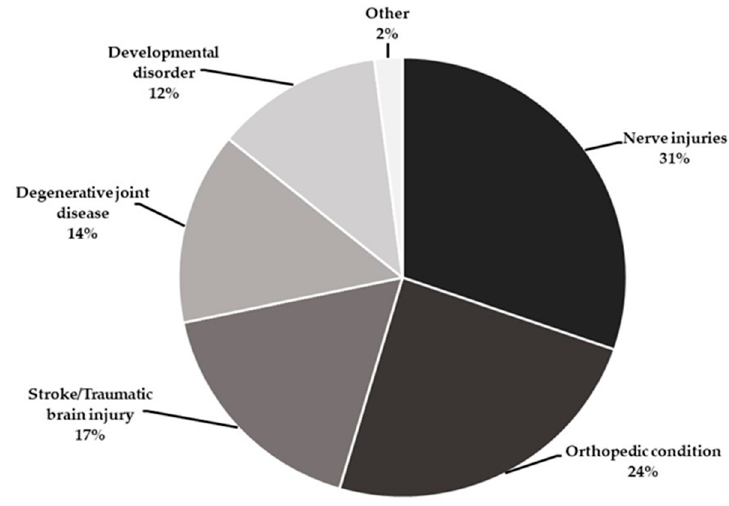
Figure 1. Distribution of clients’ conditions in splinting practice ( n = 30).